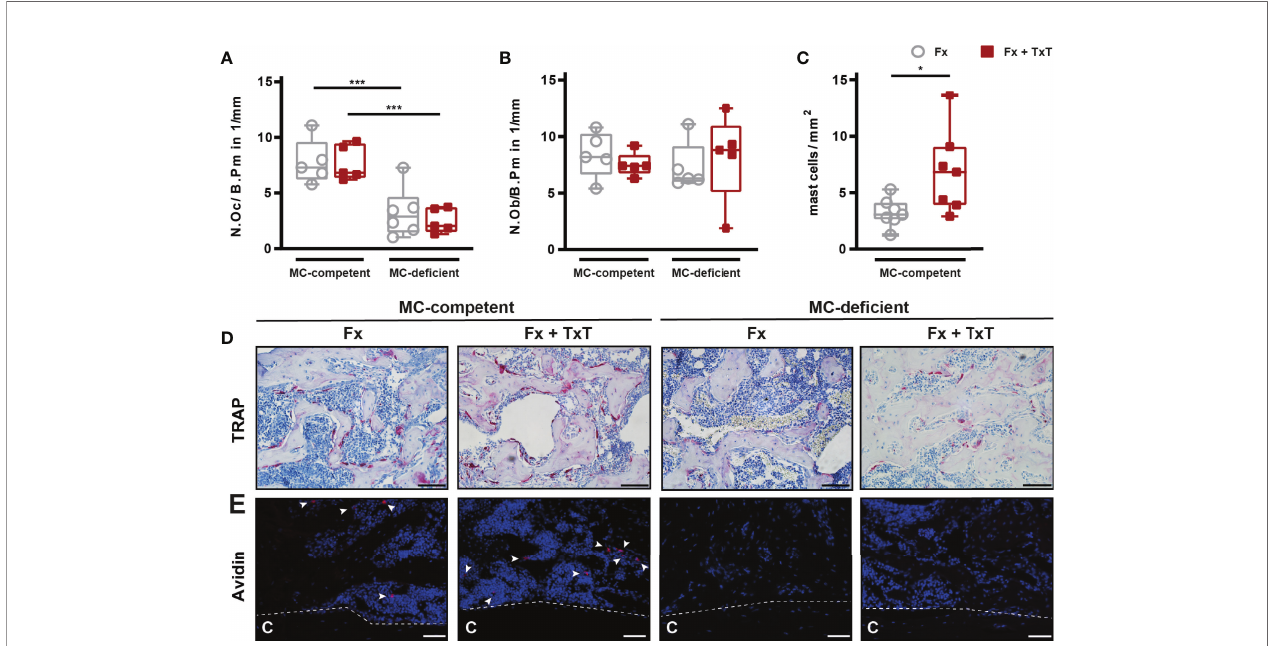
FIGURE 8 | Cellular composition of the fracture callus of mast cell (MC)-competent and MC-de fi cient mice 21 d after isolated fracture (Fx) and combined fracture and thoracic trauma (Fx + TxT). (A) Number of osteoclasts per bone perimeter (N.Oc/B.Pm), (B) number of osteoblasts per bone perimeter (N.Ob/B.Pm) and (C) number of mast cells per mm 2 . (D) Representative images from an area within the periosteal fracture callus stained for TRAP. Scale bar = 100 µm. (E) Representative images of mast cell (arrowheads) staining from an area within the periosteal callus. Scale bar = 75 µm. Gray boxes represent Fx mice, red boxes represent Fx + TxT mice, C = cortex. Data are shown as box-and-whisker plots (with median and interquartile range) from maximum to minimum, showing all data points. *p<0.05; ***p<0.001. Thep valueswere determined using one-way ANOVA with post-hoc Fisher ’ s